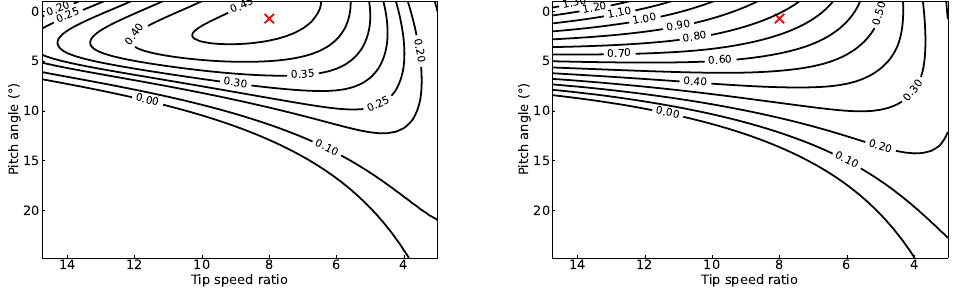
Figure 3. Contour plots of C P ( left ) and C T ( right ) for the DTU 10 MW turbine. The marker on each plot shows the operating point for Region 2b of